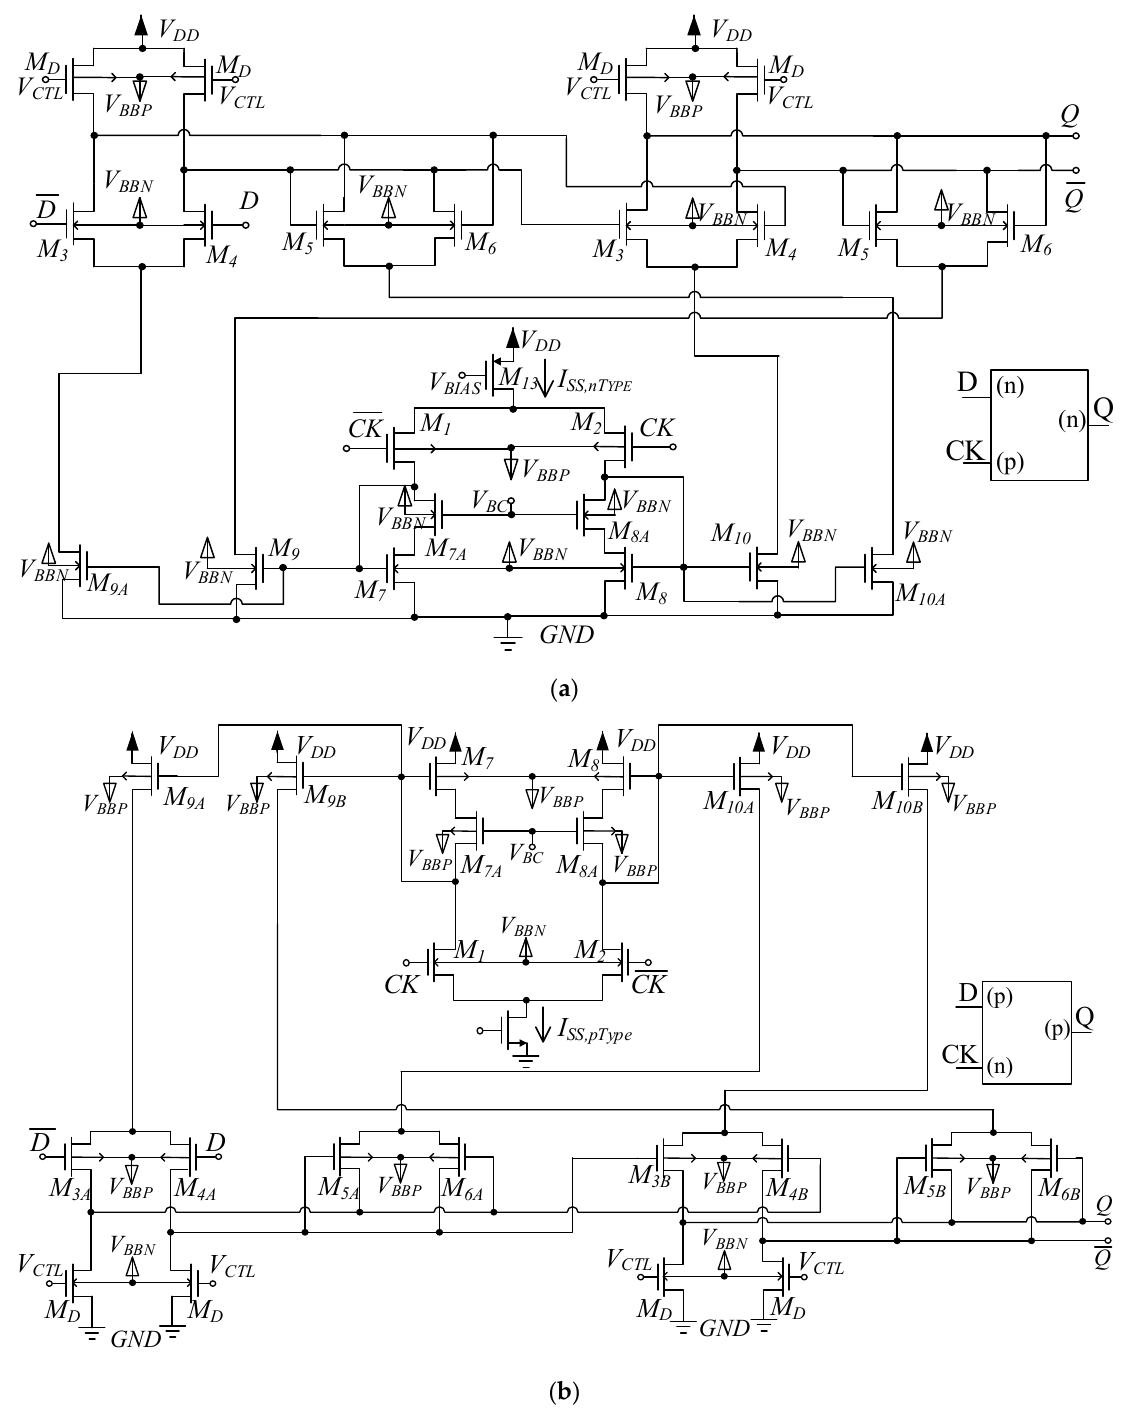
Figure 3. FMCML D Flip-Flop with FBB: ( a ) nType topology; ( b ) pType topology .